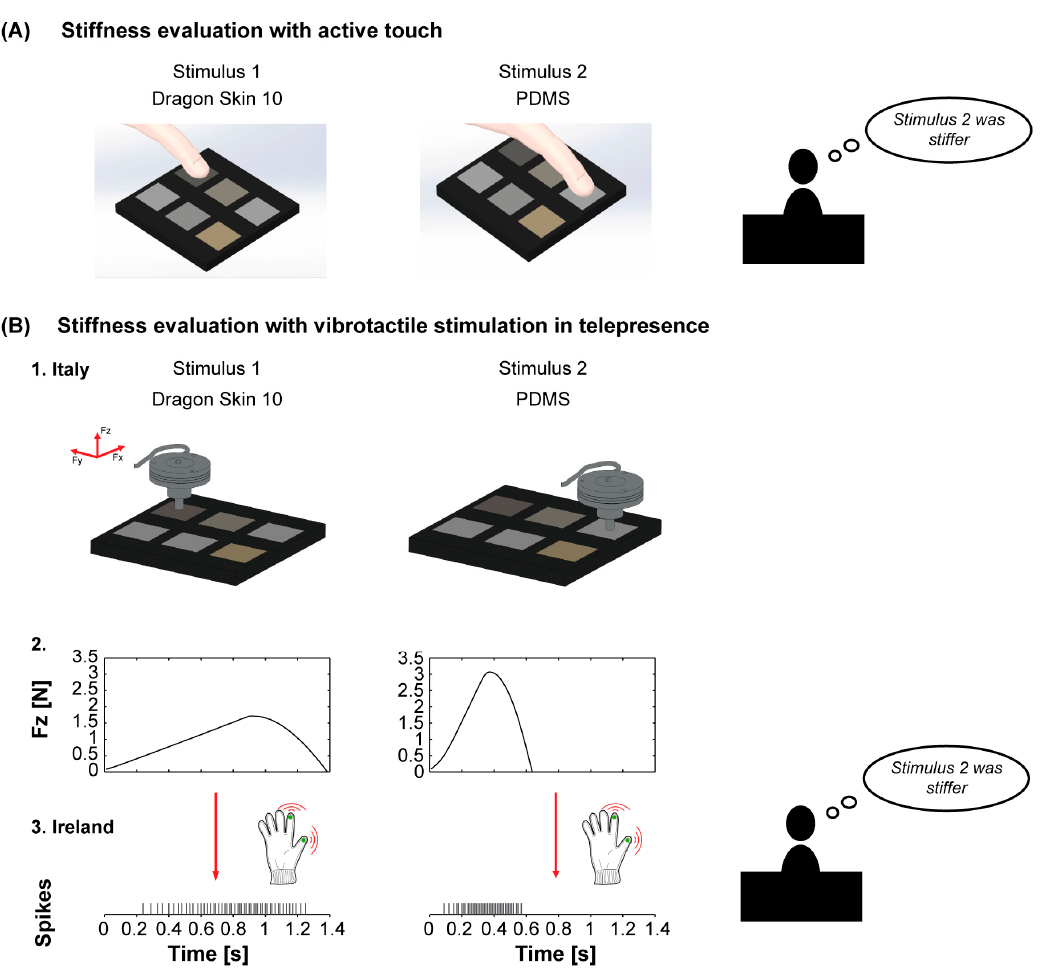
Figure 4. Experimental protocol for psychophysical experiments. ( A ) Stiffness evaluation with active touch. The participant index was guided towards the selected stimuli of the given couple. After the tactile evaluation, the participant was asked to judge which rubber of the pair was stiffer. ( B ) Stiffness evaluation with vibrotactile stimulation in telepresence. 1. The mechatronic platform, placed in a laboratory in Italy, indented the selected rubber of the given couple; 2. The measured normal force was converted in spikes using the Izhikevich artificial neuron spiking model; 3. The resulting spikes were delivered to the vibrotactile glove, placed in a remote laboratory in Ireland, for the haptic bi-digital stimulation of the participants’ hand. After the transmission of the spikes representing the second stimulus, the participant was asked to judge which rubber of the pair was stiffer.